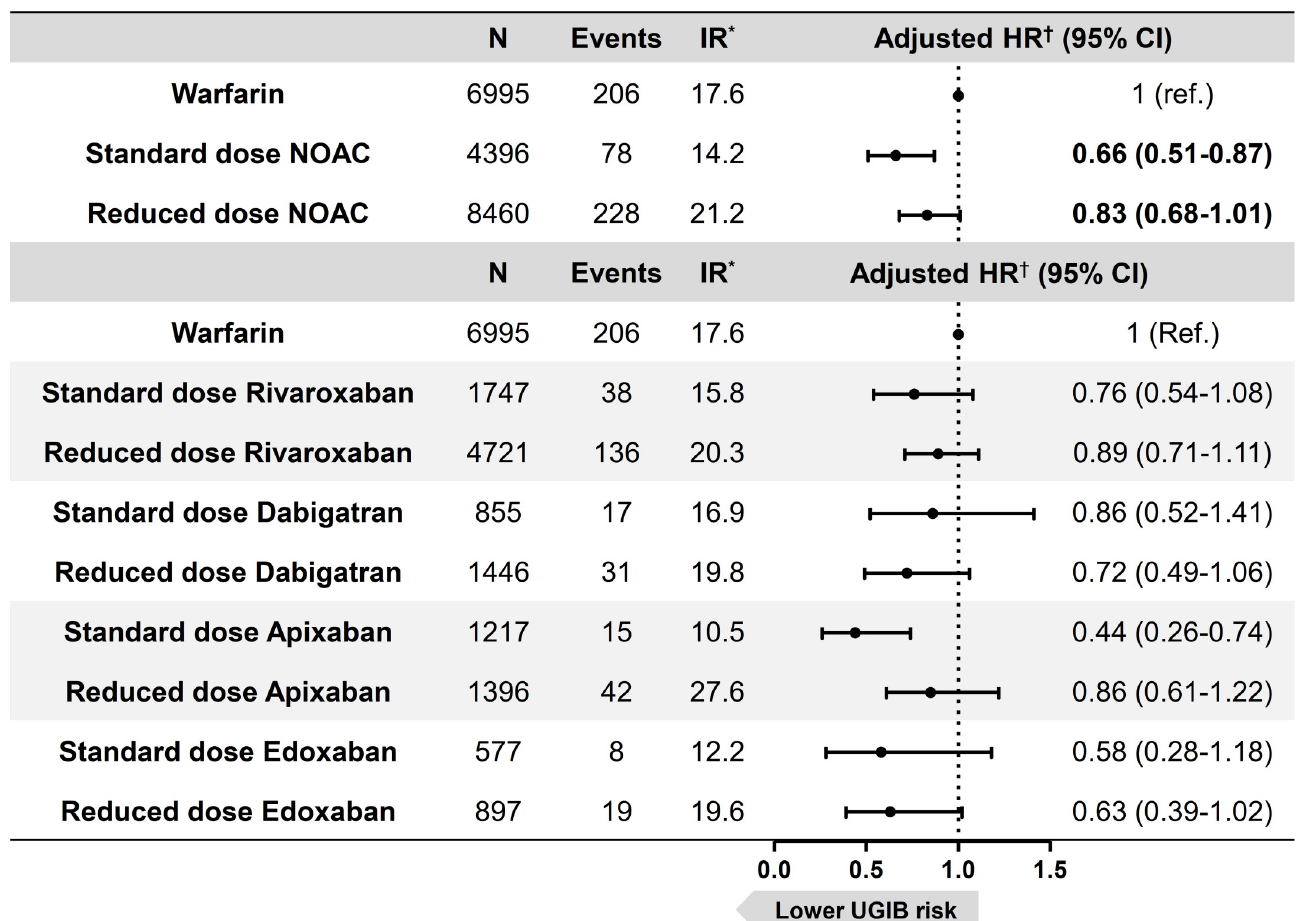
Fig 4. Comparison of upper gastrointestinal bleeding risk in users of warfarin and 4 NOACs with consideration of dose regimens. � IR: incidence rate per 1000 person-years. † Adjusted for age, sex, atrial fibrillation, venous thromboembolism, comorbidities (hypertension, diabetes mellitus, chronic kidney disease, ischemic heart disease, heart failure, peptic ulcer disease), and concomitant use of aspirin, P2Y 12 inhibitor, and nonsteroidal anti-inflammatory drug. NOAC, non- vitamin K antagonist oral anticoagulant; UGIB, upper gastrointestinal bleeding.